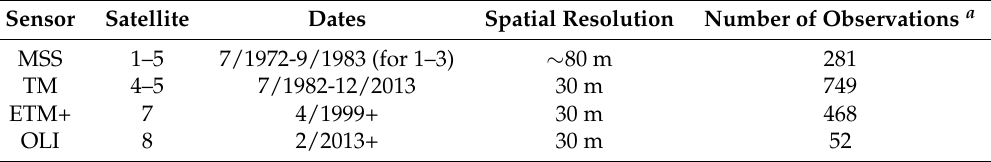
Table 1. Summary of Landsat observations. MSS, Multispectral Scanner